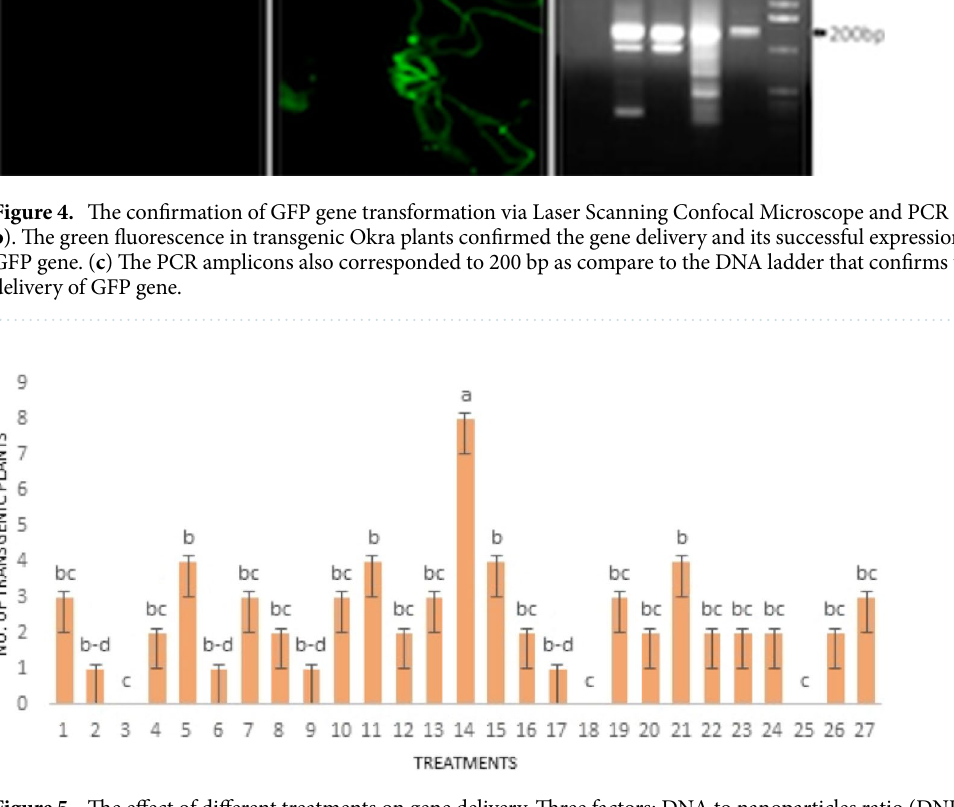
Figure 5. The effect of different treatments on gene delivery. Three factors: DNA to nanoparticles ratio (DNR), time of magnetofection (h), and revolution per minute (rpm). The treatment No. 14 yielded the highest number of transgenic plants that include 1:20 ration DNR, 5 h of magnetofection with 800